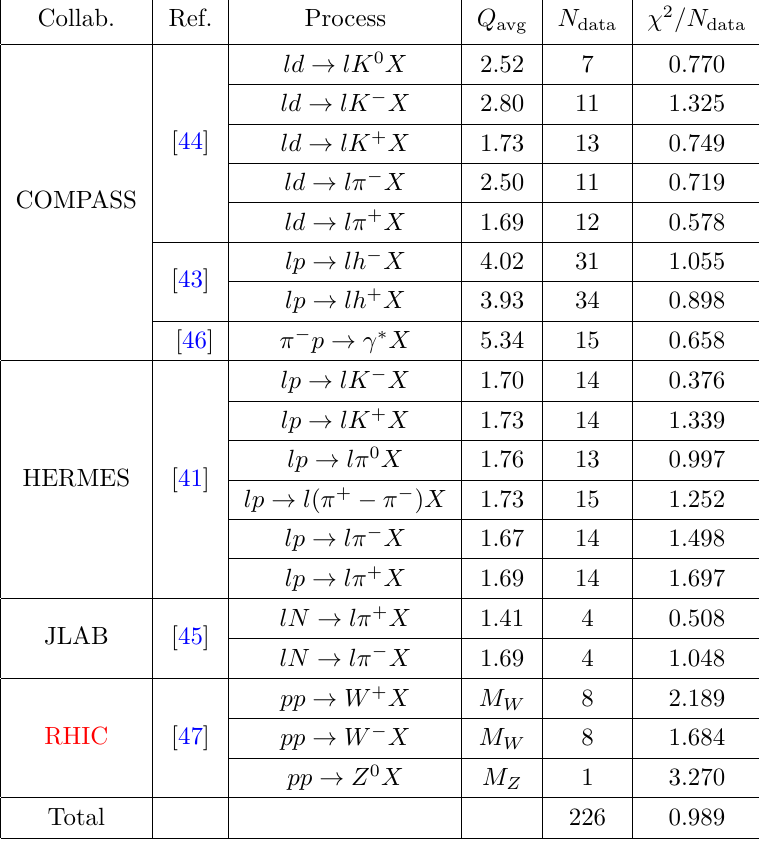
Table 3 . The distribution of experimental after taking the kinematic cuts q ⊥ /Q < 0 . 75 , P h ⊥ < 1 GeV, and z < 0 . 7 . The column Q avg gives the average hard scale for the measured data set. On the right column, we have included the χ 2 /N data for each set of data from the extraction in fit 1. The RHIC data was not included into the fit. Here we give the χ 2 /N data for the prediction.